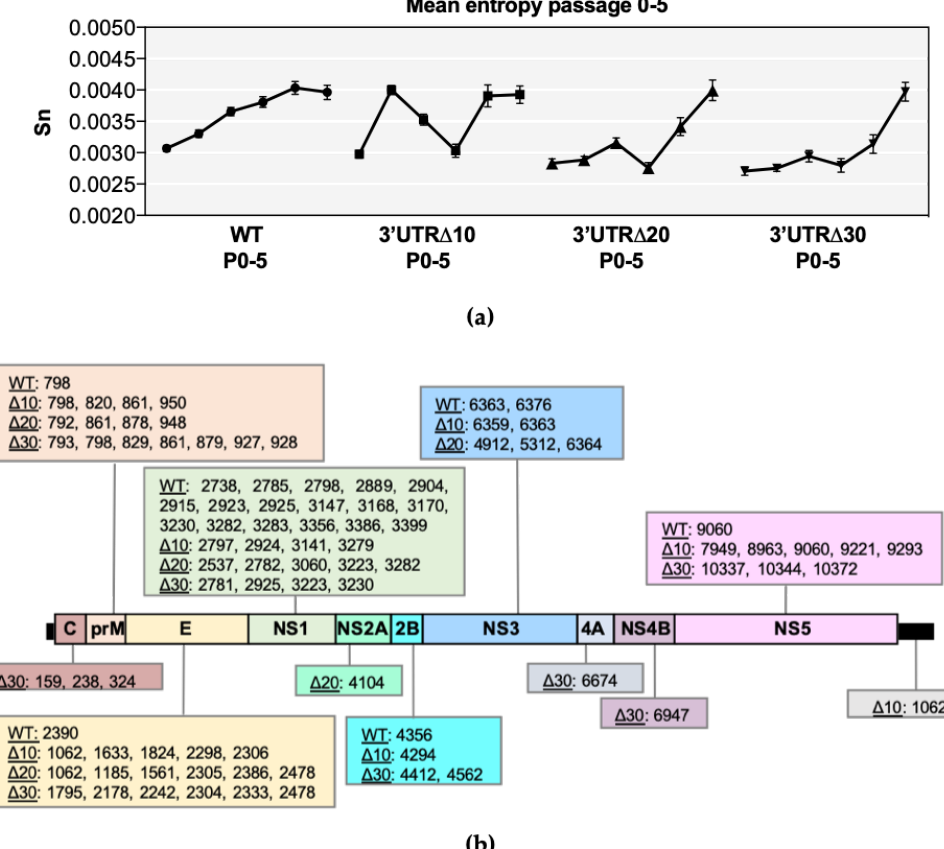
Figure 1. Entropy analysis of each virus sequence. ( a ) Symbols represent the mean value ( +/ − standard error of the mean) of positional entropy across the genome (positions 21–10750), and lines connect P0-P5 of wild-type (WT), 3’ untranslated region (UTR) ∆ 10, 3’UTR ∆ 20, and 3’UTR ∆ 30. ( b ) Nucleotide positions with increasing entropy values across multiple passages are shown for each Zika virus (ZIKV) according to the gene region/UTR. Non-parametric statistical analysis comparing the positional entropy values of each passage demonstrated that the entropy values were significant, and this is further detailed in Supplementary Table 1.